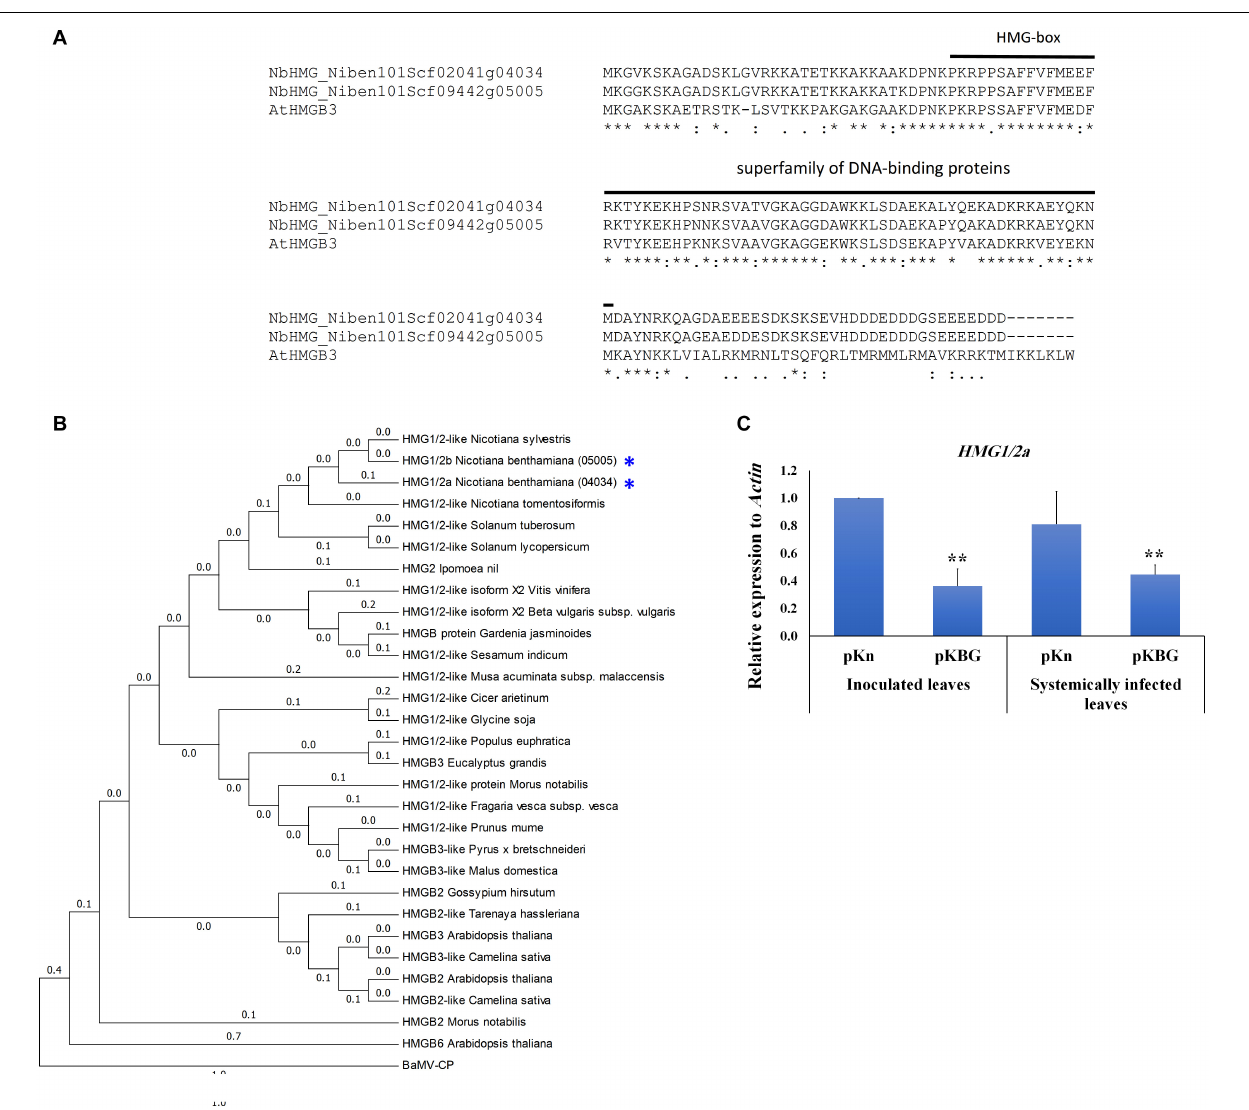
FIGURE 1 | Phylogenetic and expression analyses of Nicotiana benthamiana HMG1/2 genes. (A) Similarities of NbHMG accessions to Arabidopsis thaliana HMGB3 . Two NbHMG accessions with high similarity to AtHMGB3 were obtained by blasting the AtHMGB3 coding sequence against the N. benthamiana database (Sol Genomics Networks), i.e., NbHMG_101Scf02041g04034 ( NbHMG1/2a ) and NbHMG_101Scf09442g05005 ( NbHMG1/2b ). (B) Phylogenetic analysis of NbHMG1/2 with orthologs from other species. The HMG phylogeny was generated using the Neighbor Joining method in MEGA 6.0 software. Numbers represent relative phylogenetic distance. BaMV capsid protein (CP) was used as an outgroup to root the tree. (C) Relative expression levels of NbHMG1/2a by RTqPCR in N. benthamiana plants infected with BaMV infectious clone (pKBG) compared with plants infiltrated with empty vector (pKn). Inoculated leaves were tested at 3 days post infiltration (dpi), and the systemic leaves were tested at 6 dpi. Actin was used as an internal control. Data represent the mean ± standard deviation from three biological replicates. One-sided student t- tests were performed to determine significant differences. Asterisks indicate significant differences relative to control lines (infiltrated with pKn), with ** representing P <